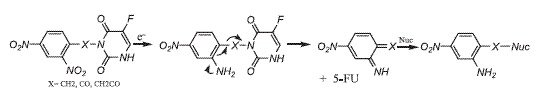
Proposed metabolic reduction of compounds X-XIII on the basis of reference 7.